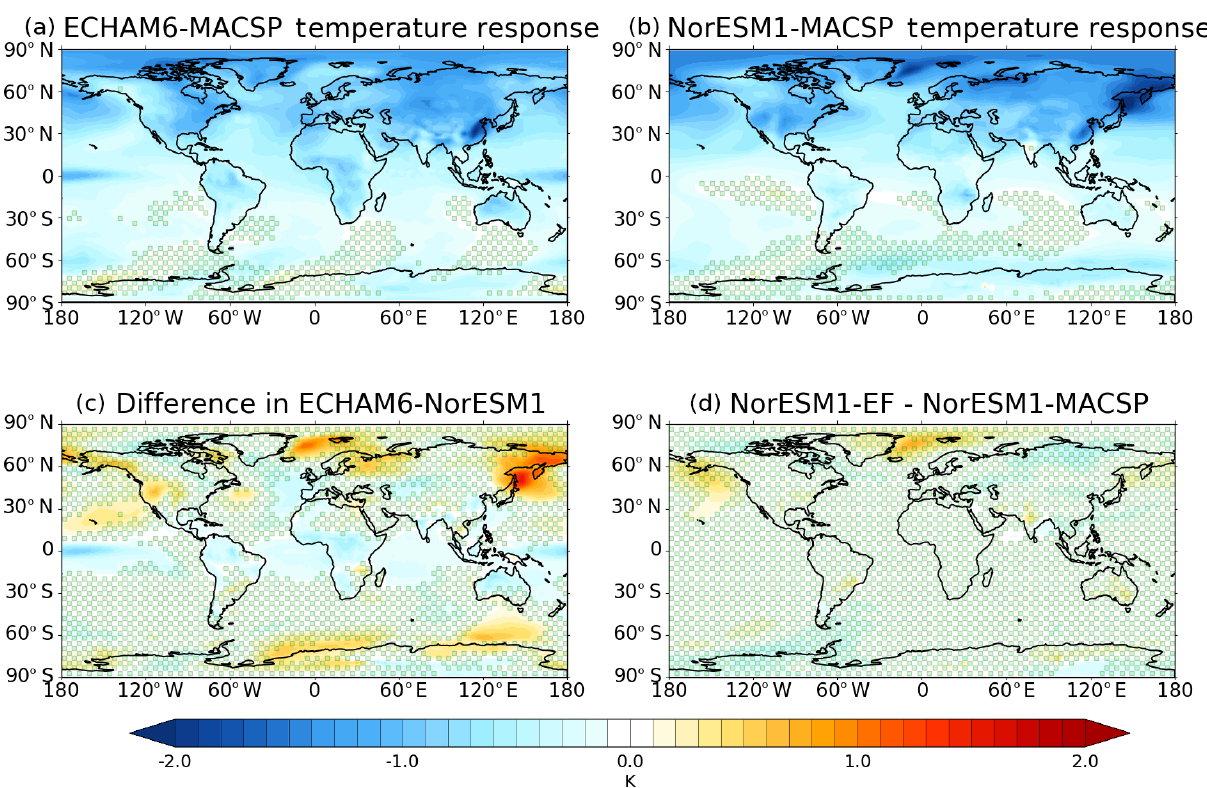
Figure 2. Near-surface temperature response to the addition of anthropogenic (MACv2-SP) aerosols. Panel (a) shows the response for ECHAM6-MACSP experiment and (b) for NorESM1-MACSP experiment. Panels (c) and (d) show the difference in the responses between the two models and difference between NorESM1-MACSP and NorESM1-EF. Small green circles mask the areas where results are not statistically significant at the p < 0 . 05 level.